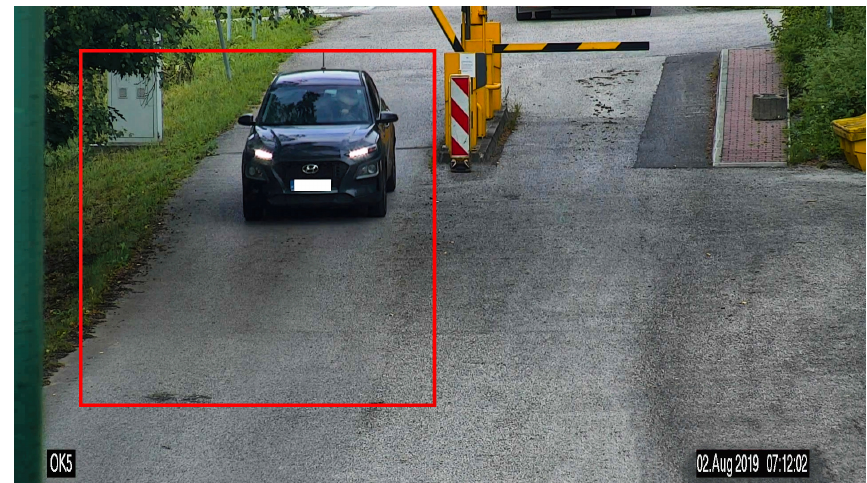
Figure 12. Entry ramp view from CCTV with the area of interest (red rectangle with a resolution of 800 × 800 px) with a timestamp.